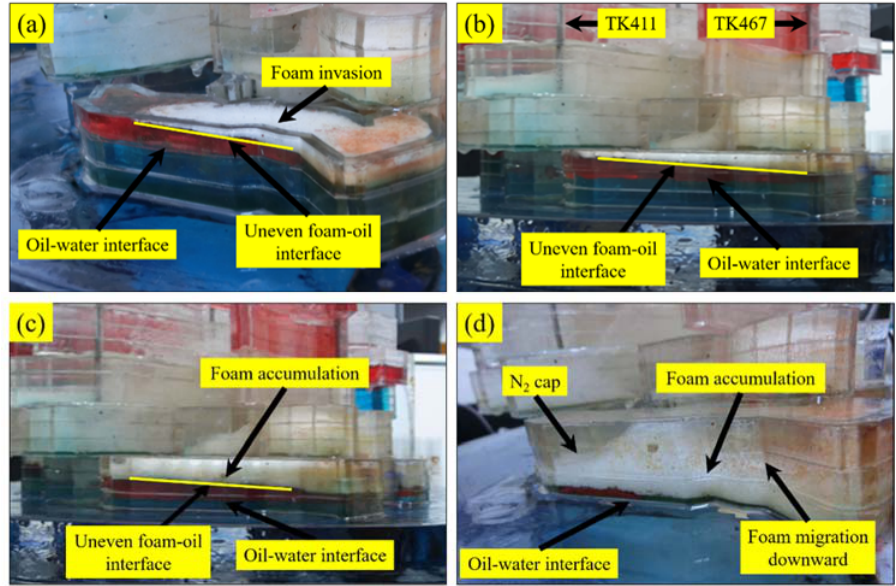
Figure 7. Synergistic effects of foam-assisted N 2 and bottom water on interface evolution: ( a ) Foam invasion, ( b , c ) Foam migration, ( d ) Formation of N 2 cap.